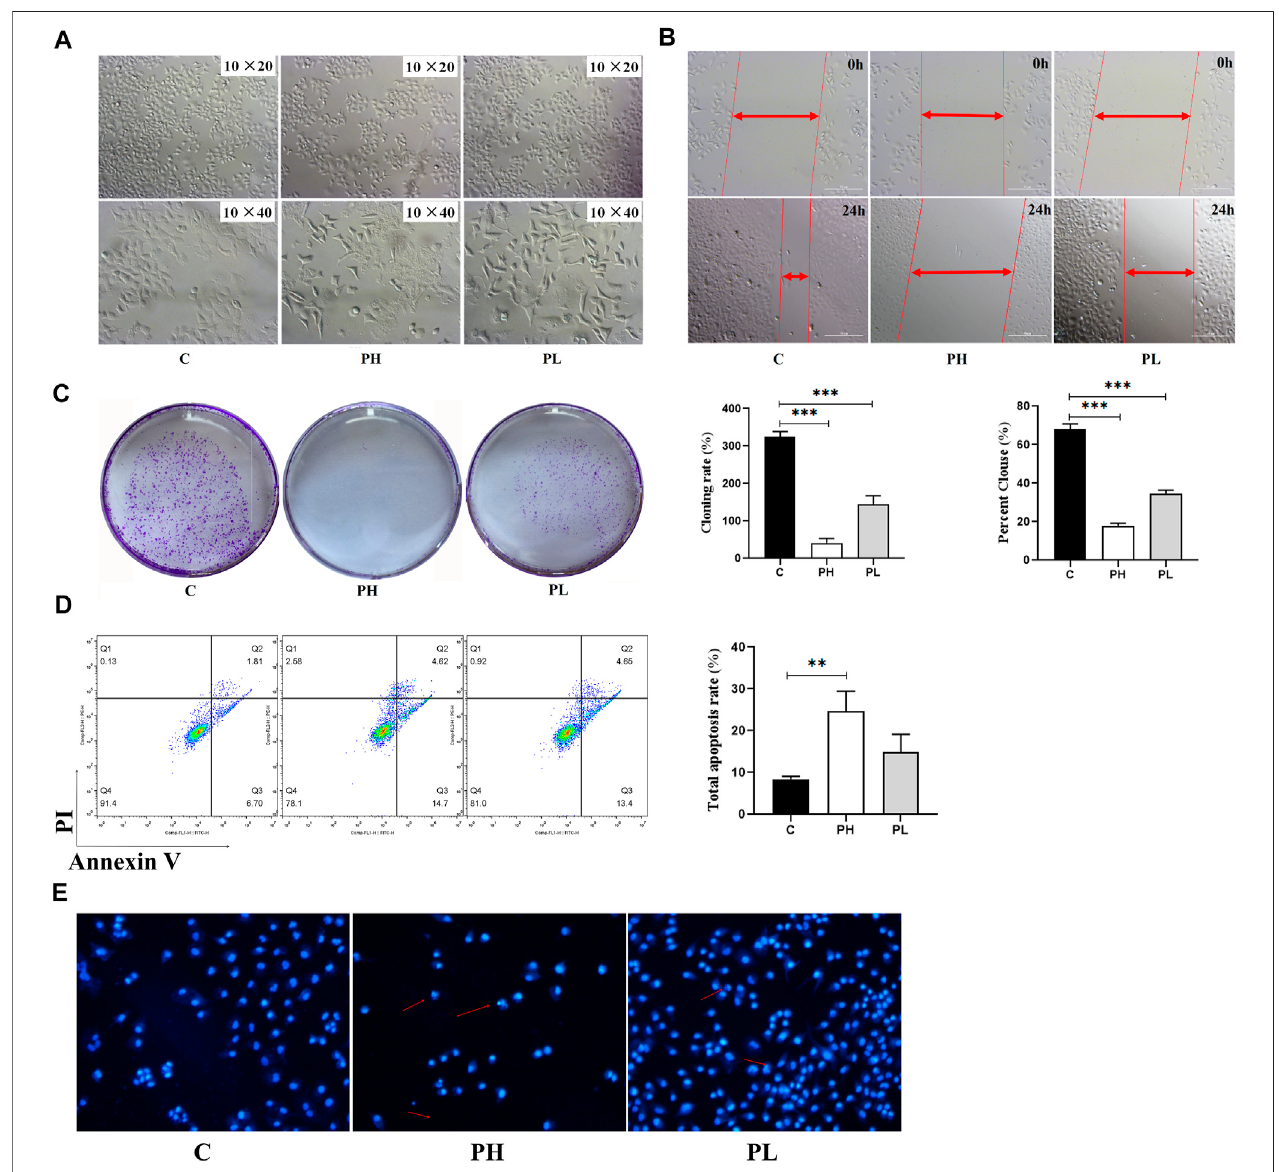
FIGURE 3 | PNS inhibited the proliferation and migration of HepG2 cells. C: control group; PH: high-dose PNS group (600 mg/L); PL: PNS low-dose PNS group (300 mg/L). (A) The morphologyimagesofHepG2 cellstreated with saline and PNS for 48 h. (B) The effect ofPNS on themigrationof HepG2cells. (C) Giemsa-stained colonies were observed under an inverted microscope. (D) FACS analysis of apoptosis in HepG2 cells. The cells were double-stained with Annexin V and PI. Early apoptotic cells were in the lower right quadrant, and late apoptotic cells were in the upper right quadrant. The histogram in the right panel showed average percentages of apoptotic cells which contained the early apoptotic cells and late apoptotic cells. (E) Fluorescence images were detected by Hoechst staining. Data are presented as the means ± SD of triplicate experiments. * p < 0.05, ** p < 0.01, and *** p < 0.001, vs. the control